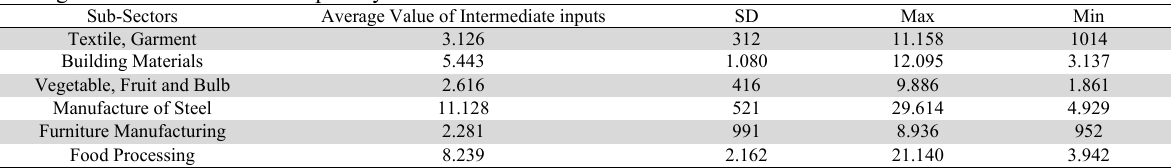
Average Value of Intermediate inputs by Sub-sectors Unit: Million VND